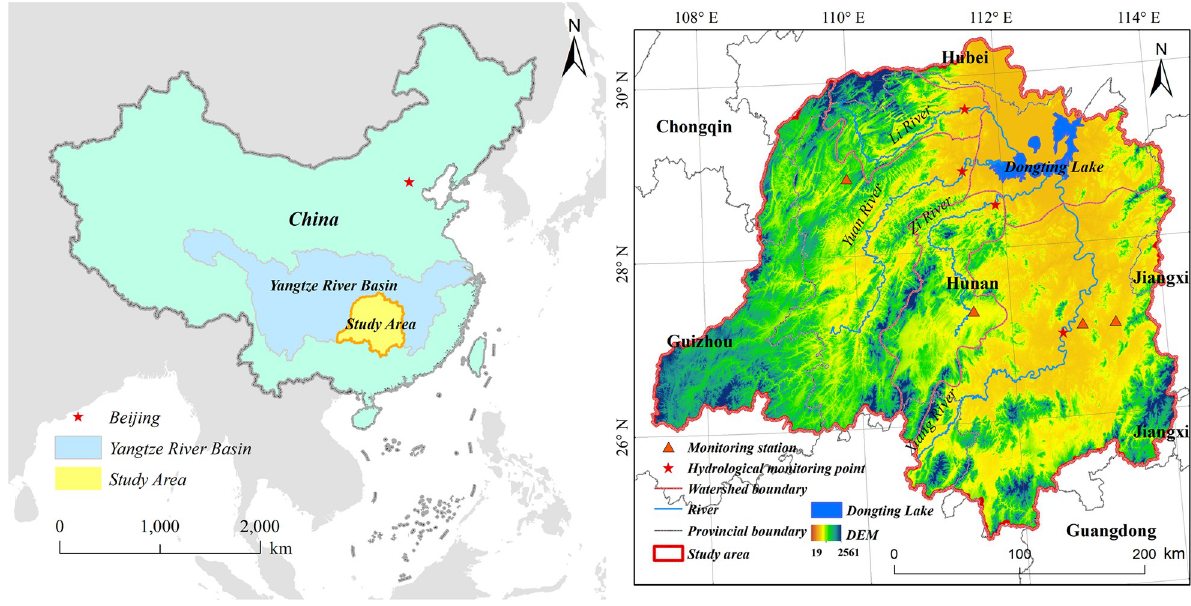
Fig 1. Location and topography of the study area. The image was created using ARCGIS 10.2 software with the authors’ data.